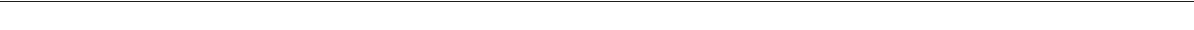
Fig. 5 Psk1 mediates the Mrc1-dependent delay upon oxidative stress. a Psk1 is phosphorylated upon oxidative stress in vivo. In vitro kinase assay of Psk1 – HA immunoprecipitated from treated cells. AP alkaline phosphatase. b Mrc1 and Psk1 interact in vivo. Co-immunoprecipitation of Mrc1 – TAP with Psk1 – HA was assayed in an in vivo pull-down assay and subsequent western blotting with the indicated antibodies. c Psk1 phosphorylates Mrc1 more ef fi ciently when activated by oxidative stress. The phosphorylation of GST – Mrc1 by HA – Psk1 immunoprecipitated from treated/untreated cells was assayed using an in vitro kinase assay and autoradiography. d Mrc1 is phosphorylated by Psk1 in vivo. This experiment was carried out as in Fig. 1a. Numbers indicate the percentage of phosphorylation relative to loading and the signal of Mrc1 phosphorylation in the wild-type strain. e psk1 Δ cells do not delay S phase upon oxidative stress. DNA replication over time was followed using FACS. f psk1 cells display higher levels of TAR upon oxidative stress than wild-type cells. Numbers are relative to recombination levels in control conditions. g psk1 cells show a higher percentage of Rad52-YFP foci upon oxidative stress. Data represent the mean and standard deviation of three independent experiments. Asterisks indicate statistically signi fi cant differences by Student's t test (* p < 0.05, ** p < 0.01, *** p < 0.005) of stress versus control